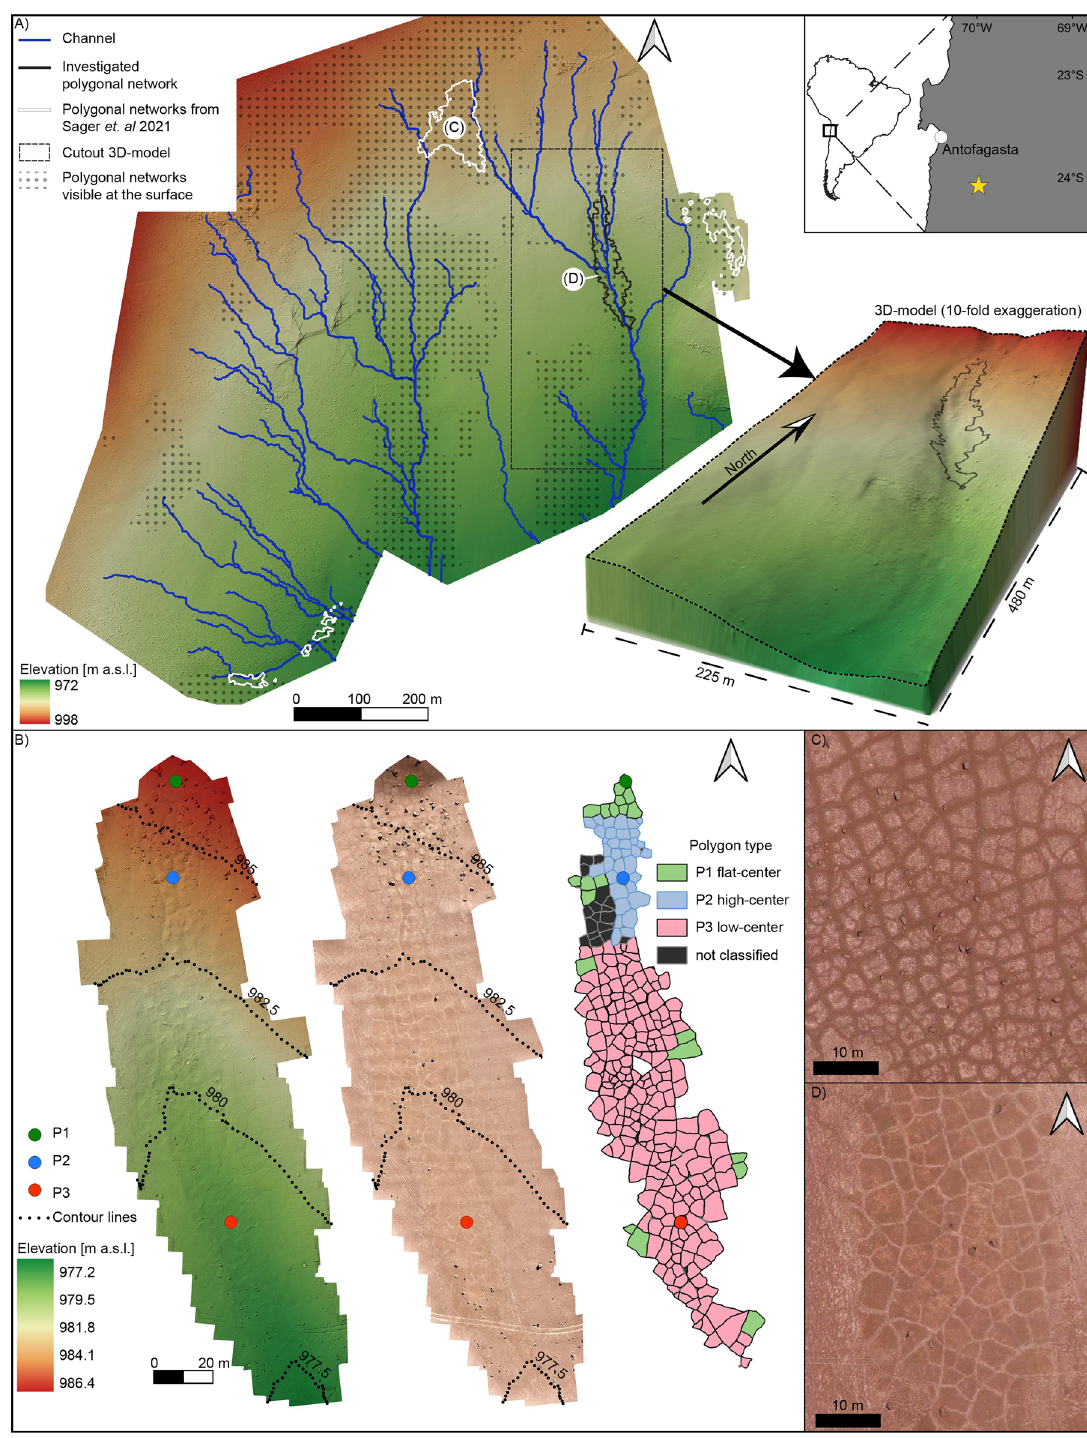
Figure 1. Color shaded digital elevation models (DEMs) and orthophotos of the study area. ( A ) The upper right box shows a location map of the study site in South America and near Antofagasta, Chile (star symbol). The DEM (overview model) shows the surrounding terrain on which the investigated polygon network (PN) is located. The 3D-model (lower right corner) with tenfold vertical exaggeration shows the PN in an inactive channel. The letters on white background show the location of Fig. 1 C,D. ( B ) Maps of the close-up model show the PN with sampling locations (P1: − 24.07846, − 69.99319, P2: − 24.07741, − 69.99338, P3: − 24.07711, − 69.99337) as a shaded DEM, as an orthophoto, and the polygon classification. ( C ) Orthophoto of a non-eroded PN outlined by dark sand wedges, while at ( D ) the polygonal pattern in P3 is inverted due to eolian erosion with polygons that appear dark compared to their sand wedges. Elevation is given in meter above sea level (m